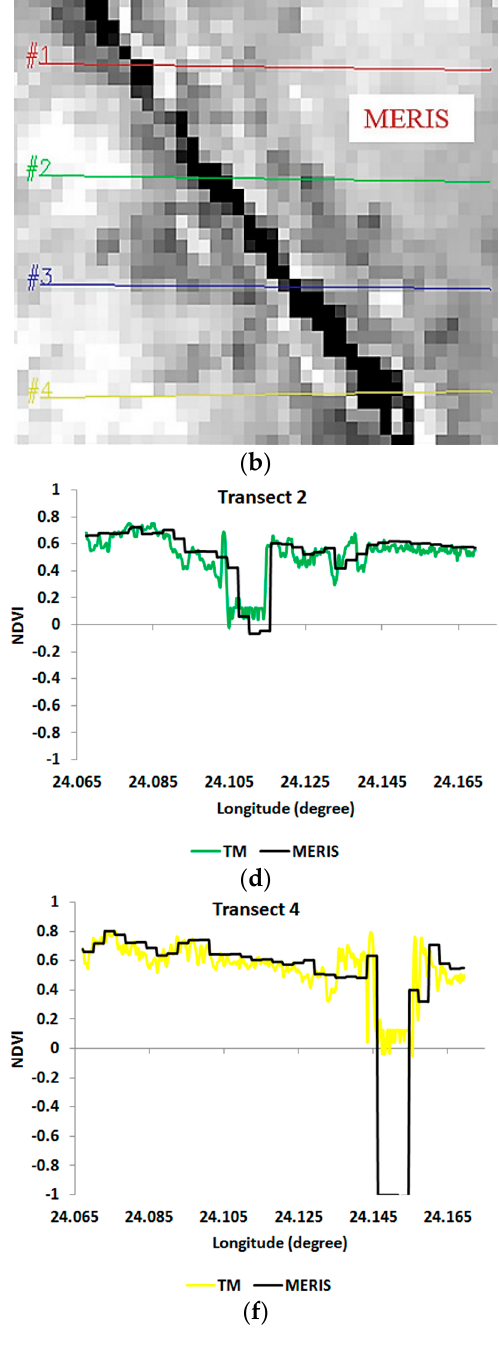
Figure 4. NDVI calculated from ( a ) TM and ( b ) MERIS images acquired on 17 April 2008 as sampled along four transects ( c – f ).